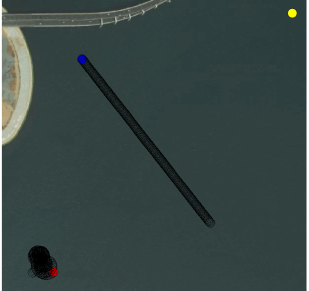
Figure 15. The effect of removing stage